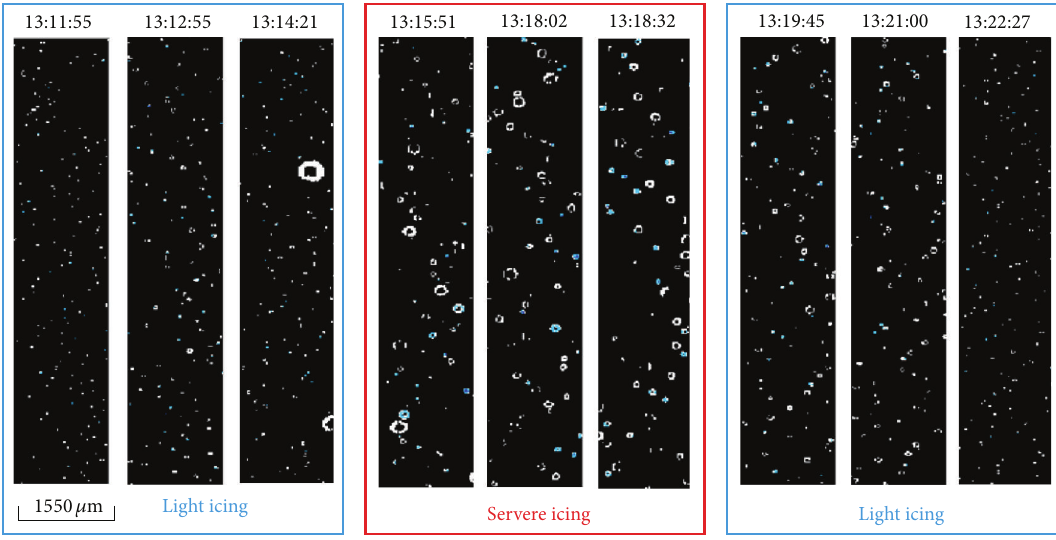
Figure 4: Images captured by CIP when aircraft experienced